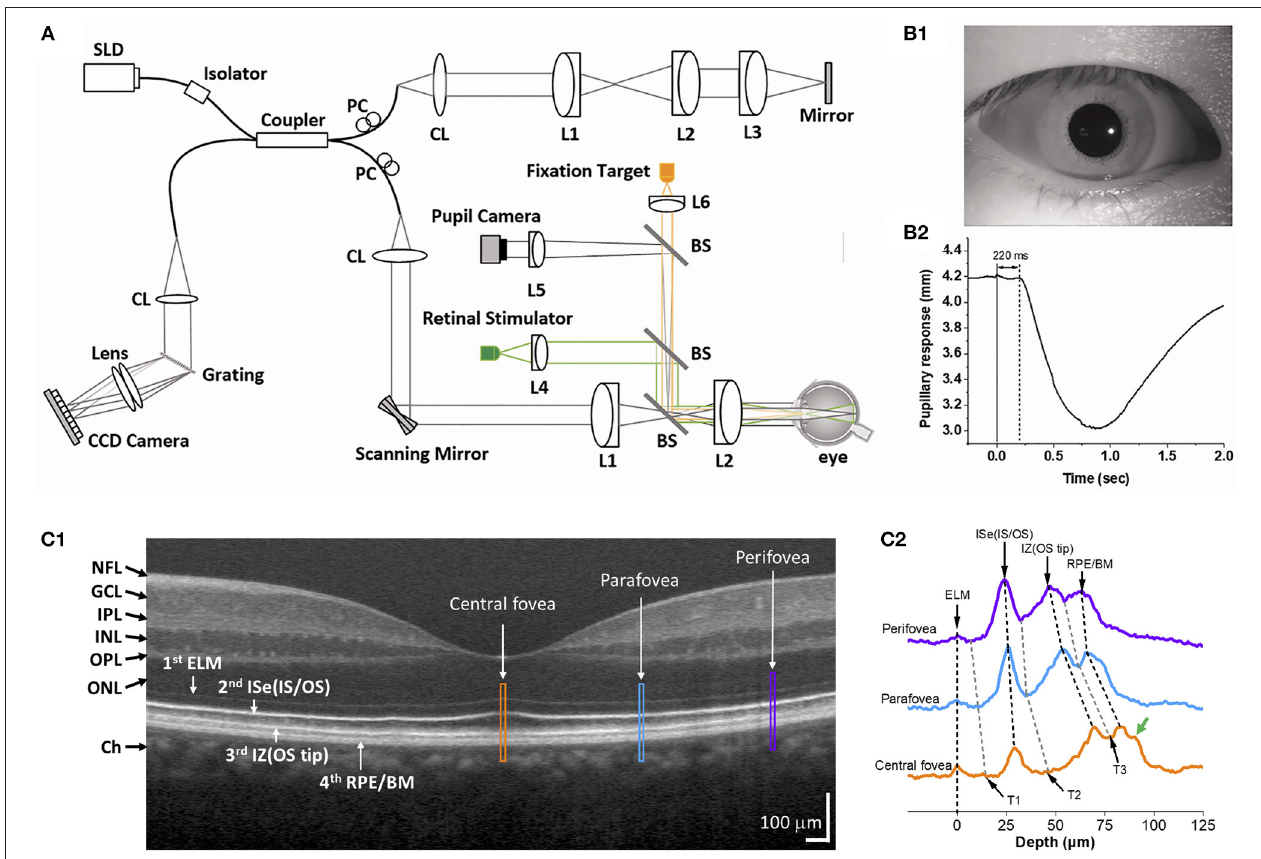
FIGURE 1 | (A) Representative functional OCT system for IOS/ORG imaging. BS, beam splitter; CL, collimation lens; Lenses, L1, L2, L3, L4, L5, and L6; PC, polarization controller; SLD, superluminescent diode. (B) Representative pupil image (B1) and pupillary response (B2) . Reprinted with permission from Son et al. (25). (C1) Representative OCT B-scan of the human retina and (C2) reflectance profiles of the central fovea (yellow), parafovea (blue), and perifovea (purple). Yellow, blue, and purple windows in (C1) indicate retinal regions for comparative reflectance profile analysis. The green arrow in (C2) indicates a possible band, i.e., Bruch’s membrane. T1–T3 indicate trough positions along the reflectance profiles. NFL, nerve fiber layer; GCL, ganglion cell layer; IPL, inner plexiform layer; INL, inner nuclear layer; OPL, outer plexiform layer; ONL, outer nuclear layer; ELM, external limiting membrane; ISe, inner segment ellipsoid; OS, outer segment; IZ, interdigitation zone; RPE, retinal pigment epithelium; BM, Bruch’s membrane. Modified with permission from Yao et al. (